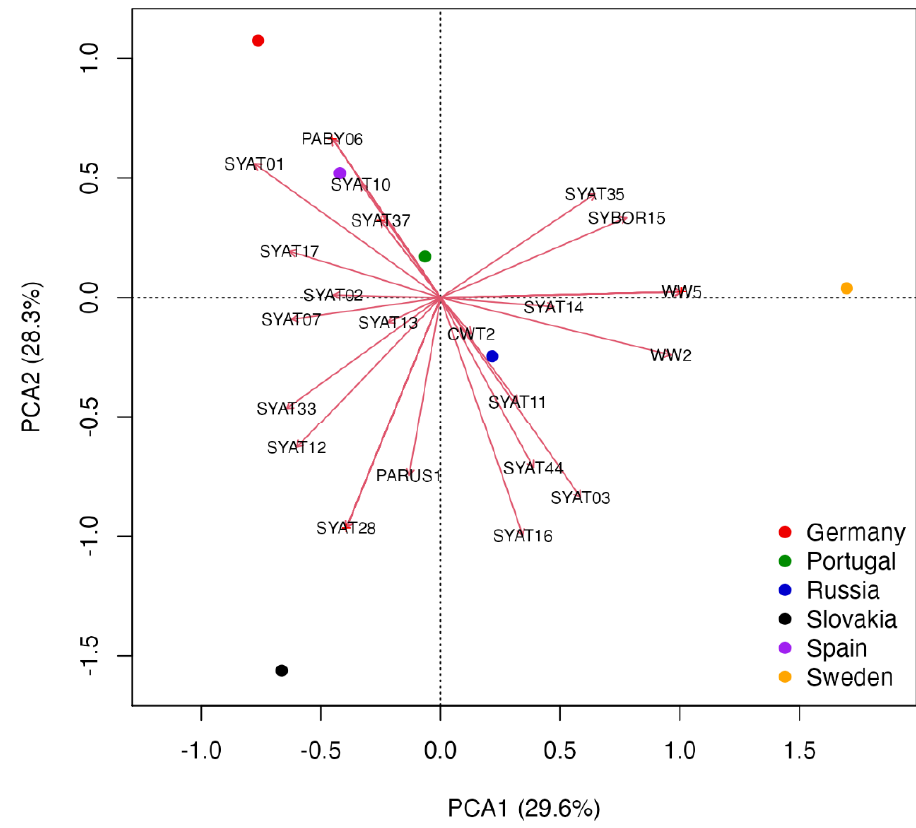
Figure 6. Principal component analysis biplot of haemoproteid abundance data at six study sites in Europe. The scaling 1 biplot shows centroids representing site scores and arrows representing haemoproteid abundance scores. Red crosses show locations with overlapping lineages, in which cases the relatively most abundant lineage is shown (see Table S4 for PCA lineage scores).